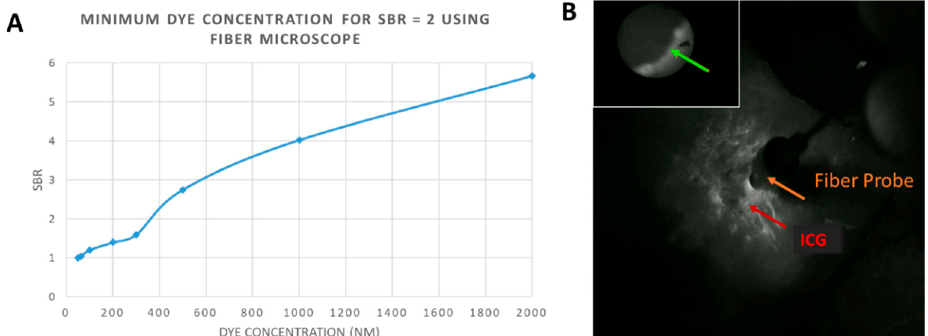
Figure 3. Multiscale functional imaging. ( A ) Plot of Signal-to-Background Ration versus Dye Concentration for the fiber optic microscope, when detecting indocyanine green (ICG) in a tissue phantom. The background of the phantom was set at a 50 nM ICG concentration; ( B ) Single frame from the wide-field fluorescence imaging cameras with the fiber microscopic imaging displayed in the top left corner. A microscopic fluorescent boundary not resolved by the wide-field cameras is indicated by the green arrow. The red arrow indicates ICG fluorescence in the NIR spectrum, and the fiber optic probe tip can be visualized in use.